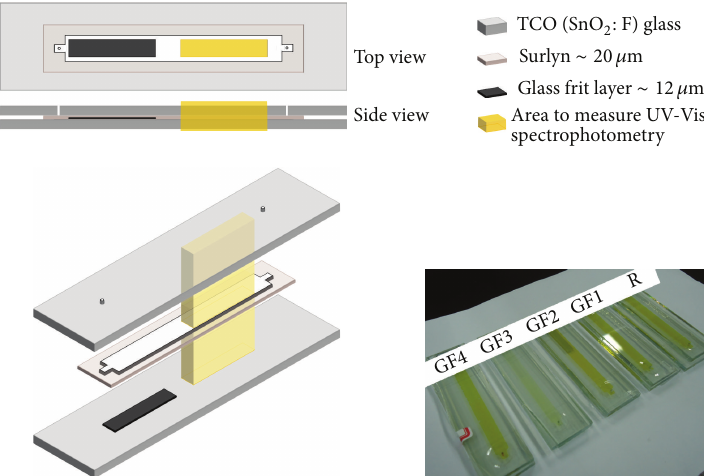
Figure 2: Cell design for investigating the accelerated influence of GF and H 2 O in the DSC electrolyte. Restricted area with a thin layer of GF and an area for absorbance measurements through the cell. The photo displays the test cells with 10wt% H 2 O in the redox electrolyte after 100 days. R indicates the reference cell (no